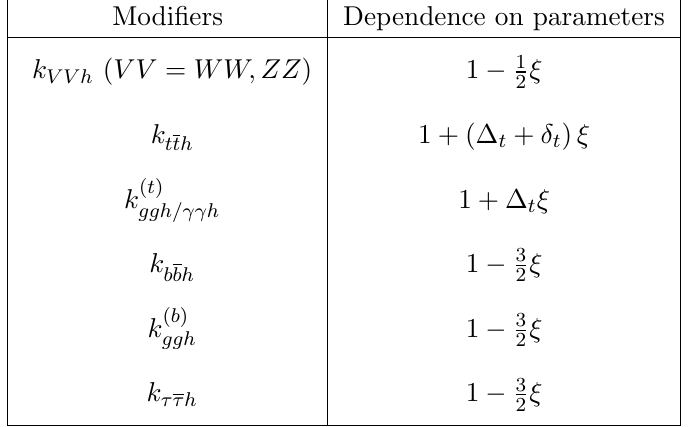
Table 2. Scaling of the Higgs e(cid:11)ective couplings for SO(5) = SO(4)